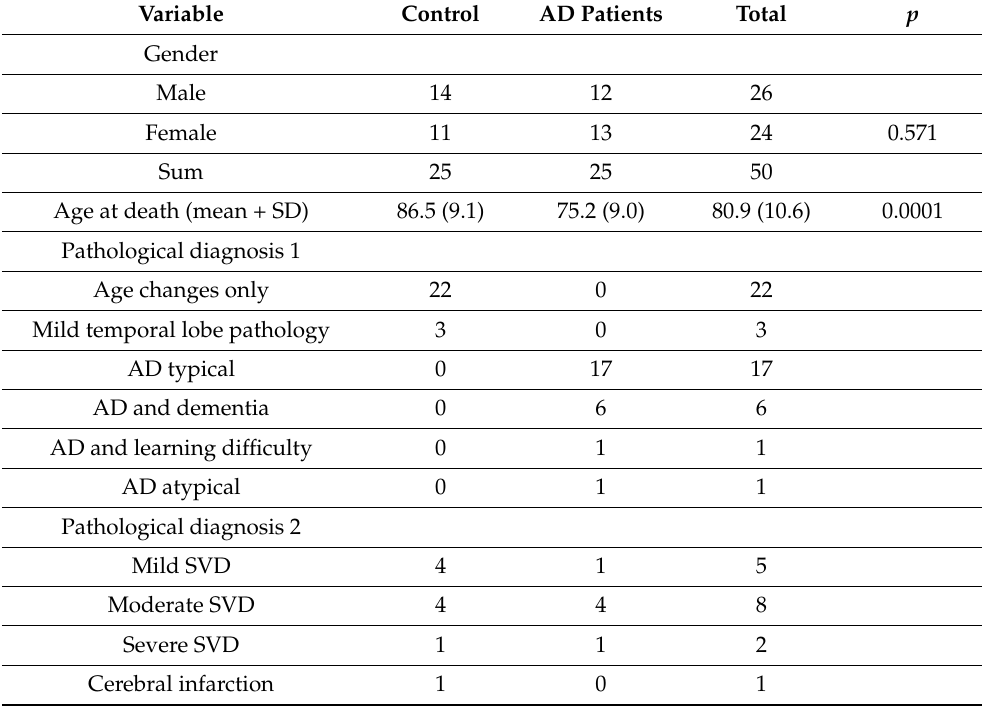
Table 2. Clinical and phenotypic differences between Alzheimer’s disease (AD) patients and normal ageing control